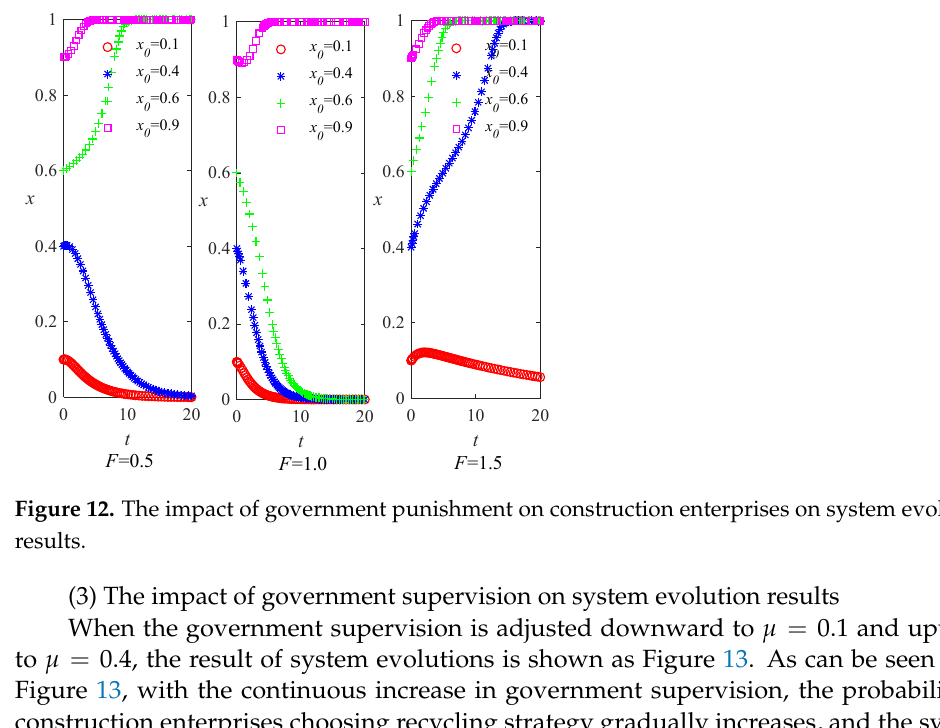
Figure 11. The impact of government subsidy to recycling enterprises on system evolution results.